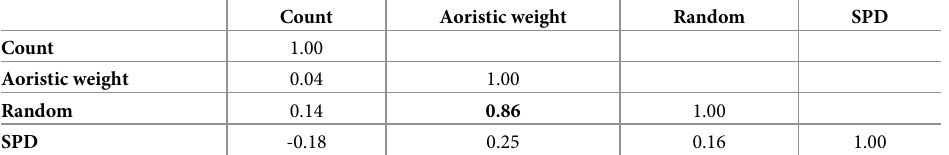
Significant correlations indicated by bold numbers (p-value < 0.05).